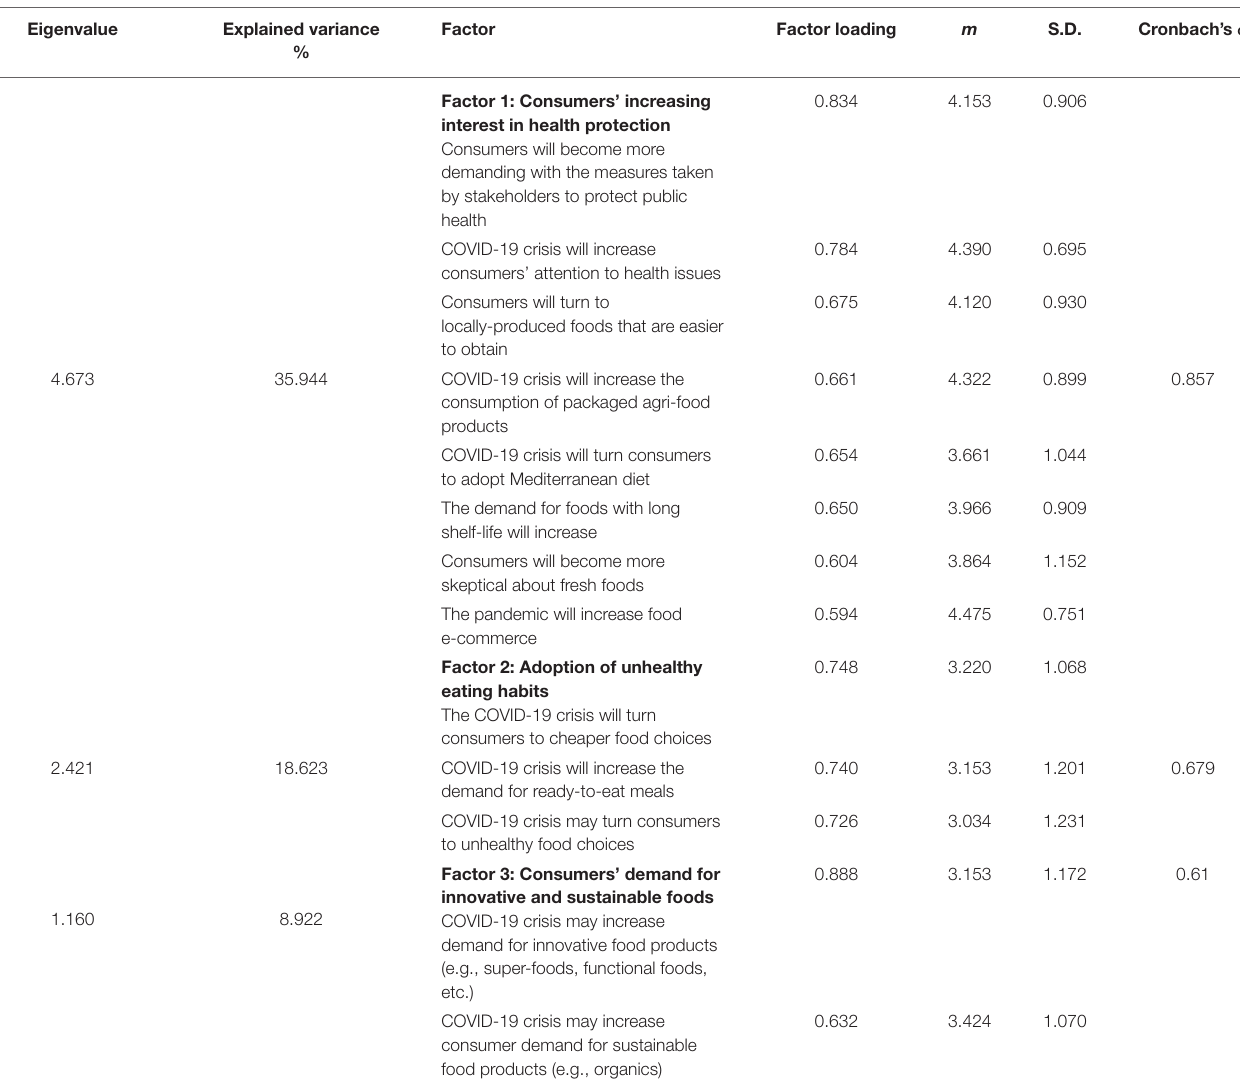
TABLE 9 | Factor analysis (PCA) and reliability analysis output on experts’ perceptions toward the impact of COVID-19 crisis on consumers’ food habits.